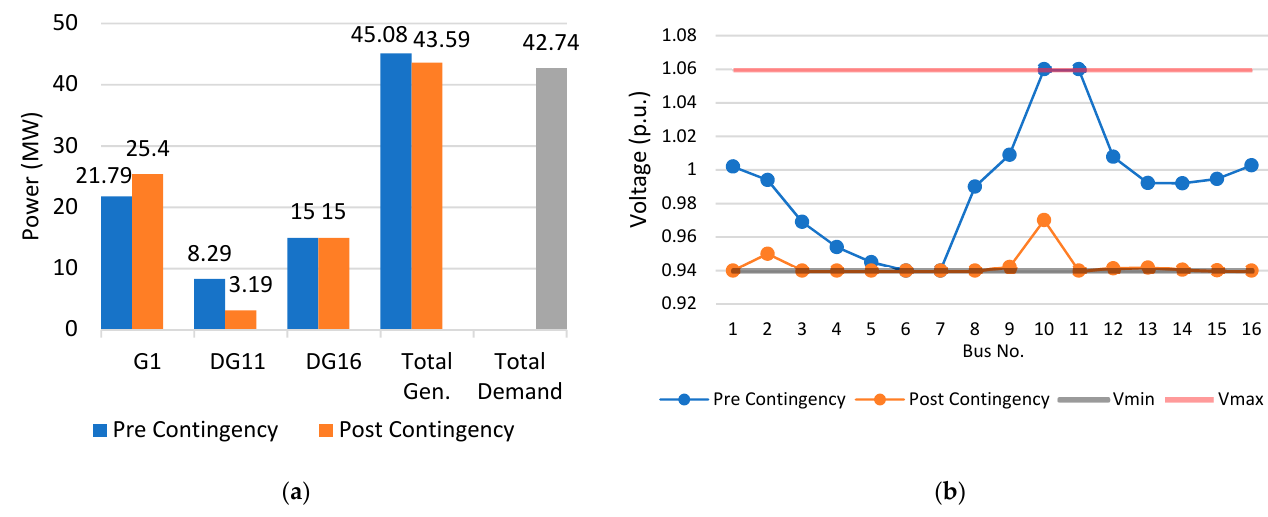
Figure 8. Scenario S3, year Y5: pre- and post-contingency results considering line L4 in contingency. ( a ) Power generation and demand, ( b ) voltage at each bus.